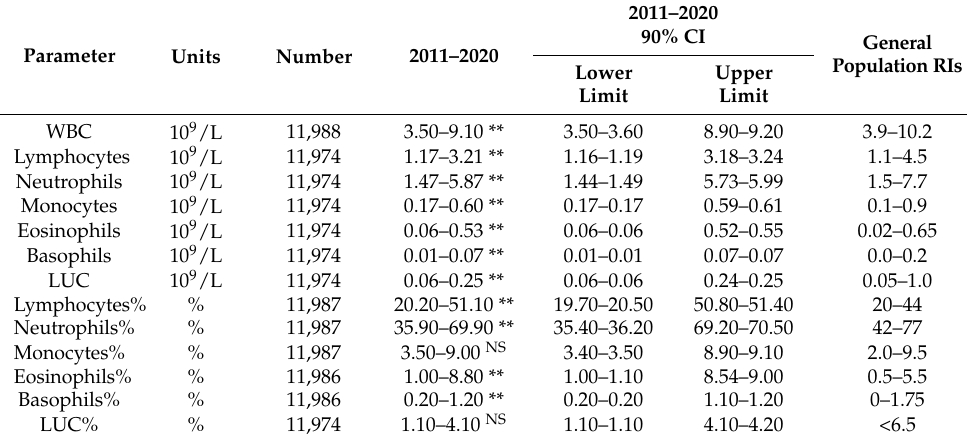
Table 5. Reference intervals (RIs) and basal values for total leukocytes cells and leukocytes subpopu- lations (females and males).